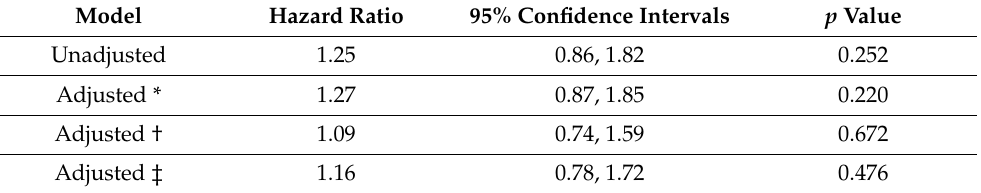
Table 3. Association of anticoagulant prescription with major adverse cardiovascular